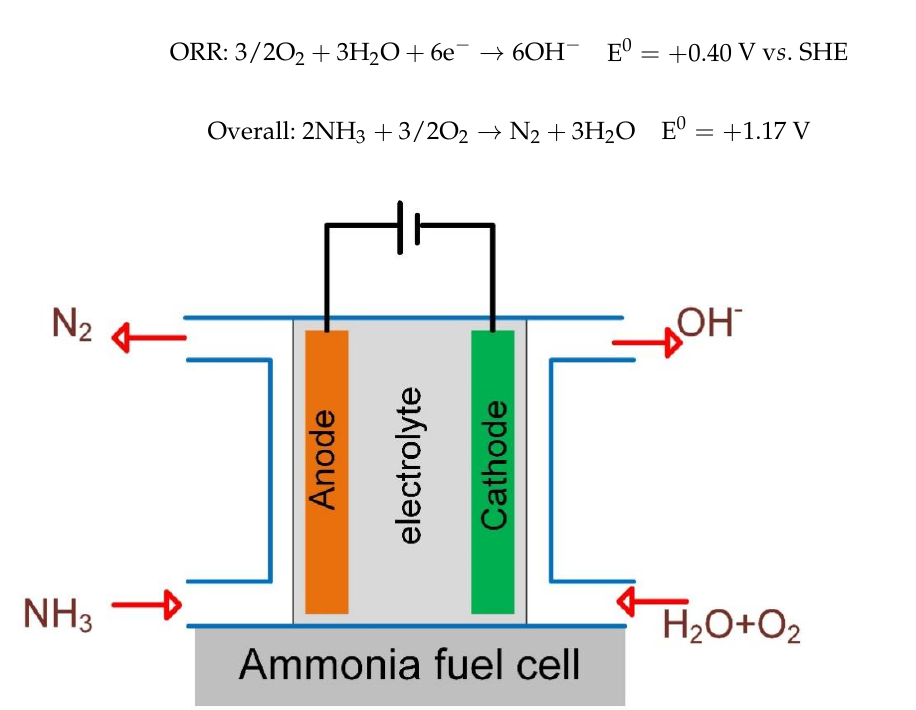
Figure 1. Schematic diagram of ammonia fuel cell.